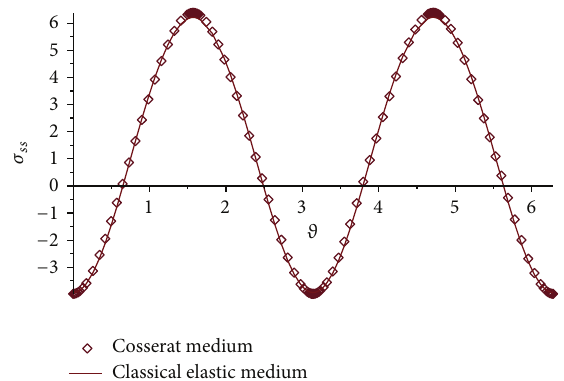
Figure 10: Domain 𝑉 in which the nonlocal problem of plane elas- ticity is